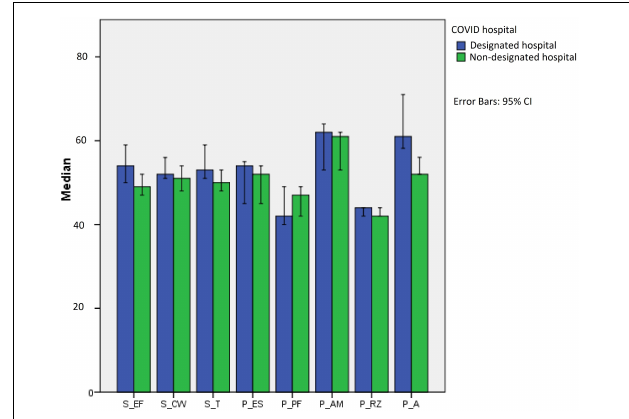
FIGURE 1 | The endler multidimensional anxiety scales anxiety scores’ differences between the designated hospitals and non-the designated